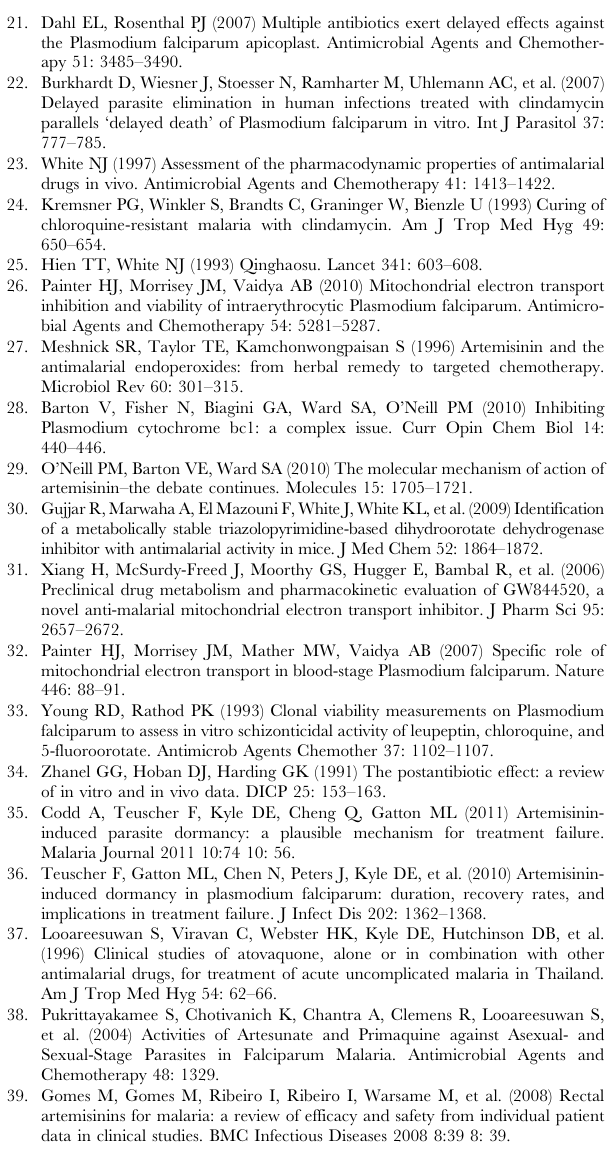
Figure S5 Comparison between in vitro and in vivo PRR data. In vivo PRR data have been estimated from available clinical trial data and are compared to the in vitro PRR values determined in this study. Drug ranking is generally conserved between the in vitro and in vivo situations, with the exception of pyrimethamine. Of note, pyrimethamine in vivo value is derived from data obtained in combination with sulfadoxine. Artemether (arte), lumefantrine (lum), chloroquine (chq), pyrimethamine (pyri), mefloquine (mef), azithromycin (azi). In vivo PPR value for artemether and lumefanterine were calculated from clinical trial data available on the Food and Drug Administration website (http://www.fda. gov/ohrms/dockets/ac/08/briefing/2008-4388b1-02-Novartis. pdf). Table S1 50% inhibitory concentration (IC 50 ) of drugs used in this study as determined by radio-labeled hypoxanthine incorporation.